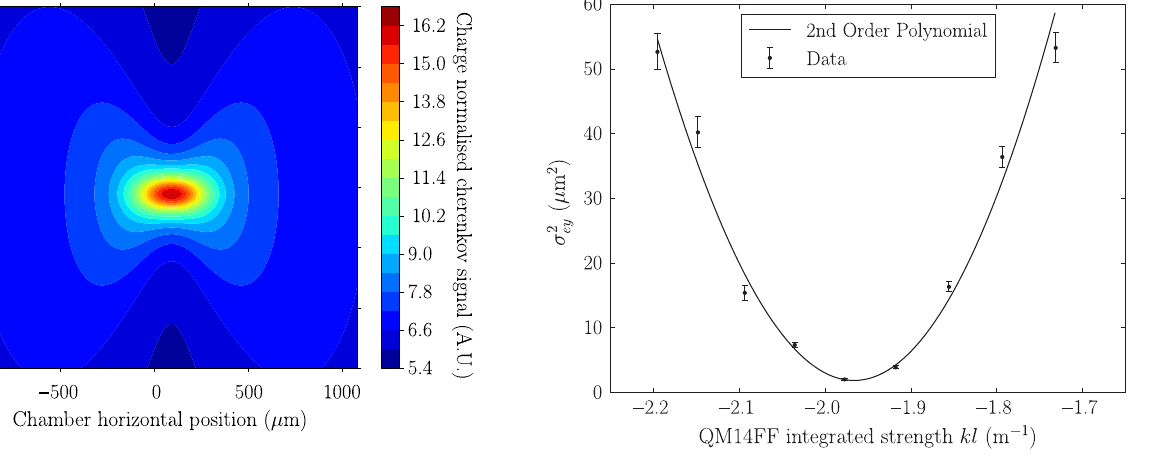
FIG. 23. Measured electron beam size squared as a function of QM14FF strength. The least squares fit to a parabola for the emittance extraction is